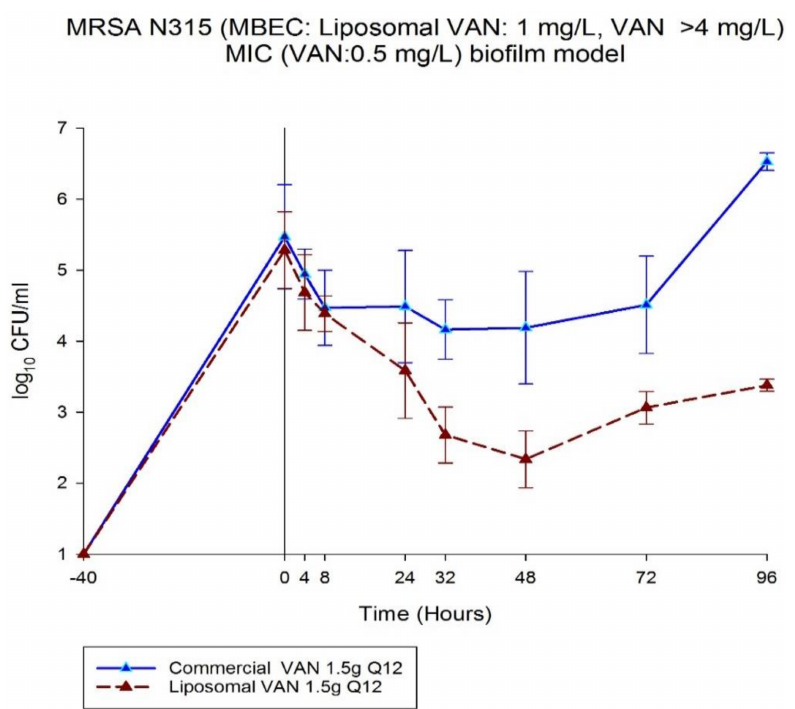
Figure 5. Superior in vitro bactericidal effect of LVAN in comparison to free VAN in MRSA N315 biofilm model is shown.